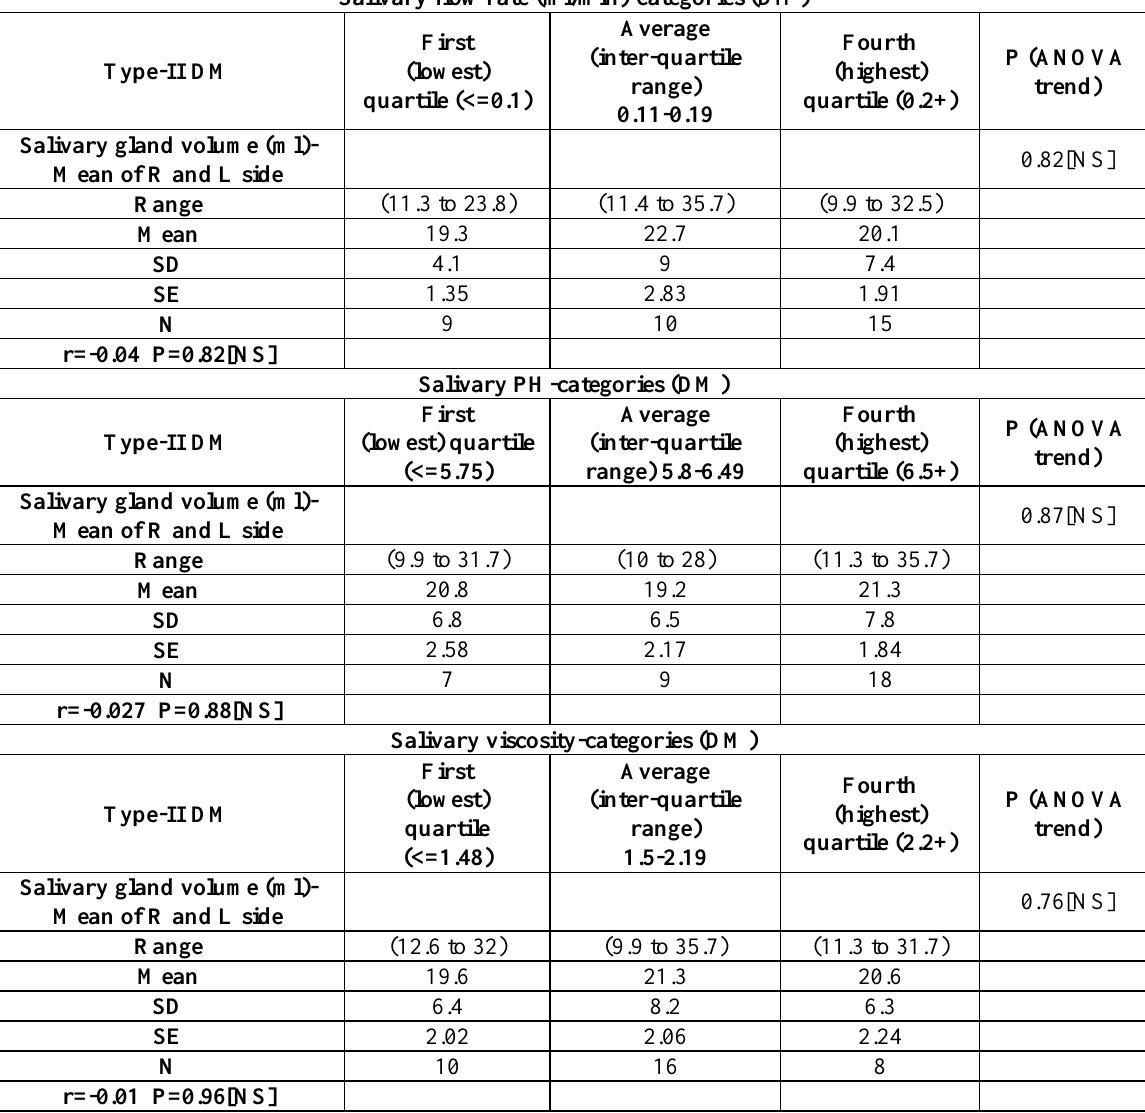
Table 4: The association between the physical properties of saliva with the SG measurements